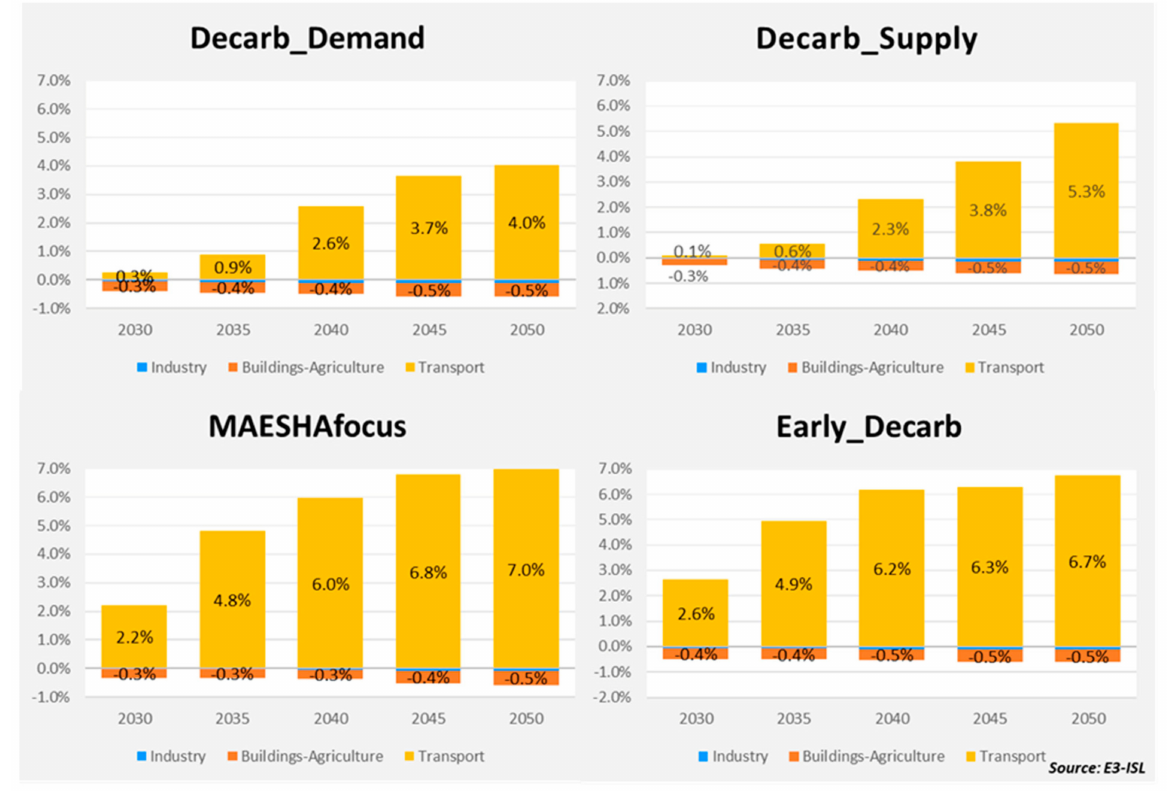
Figure 11. Energy system cost difference as % of GDP by scenario relative to Baseline scenario.